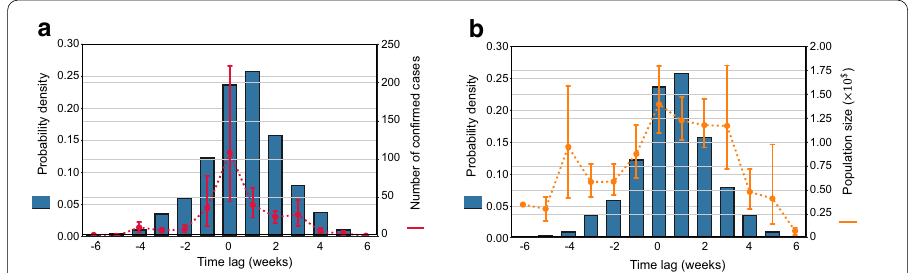
Fig. 3 Probability density function of time lags between the co-location degree centrality and the second-order growth rate of the cases, a with number of confirmed cases on March 31, 2020 (red); and b with population size (orange). The error bar represents the two-side 95% confidence interval. Some counties with extreme numbers of confirmed cases are considered outliers and are not included. (Statistics of the time lags: mean: 0.6, median: 1.0, variance: 2.9, 95% confidence interval: [0.53,